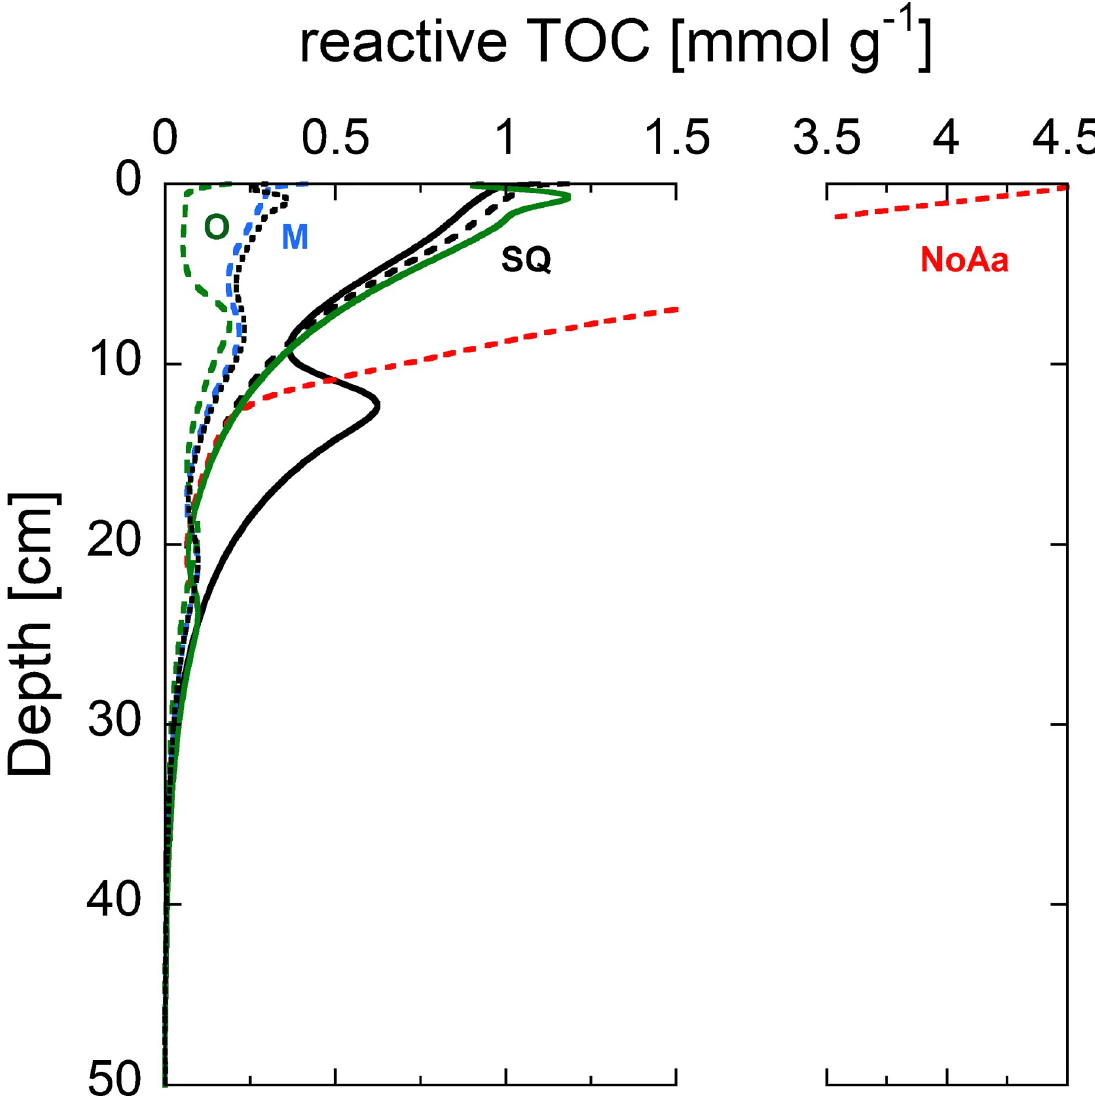
Fig 7. Modeled concentrations of reactive TOC in the different scenarios in 2050 (dashed lines). The large accumulation of reactive TOC in the NoAa scenario (red dashed) is due to anoxic conditions. The solid black line represents modeled reactive TOC concentrations in 2015 for